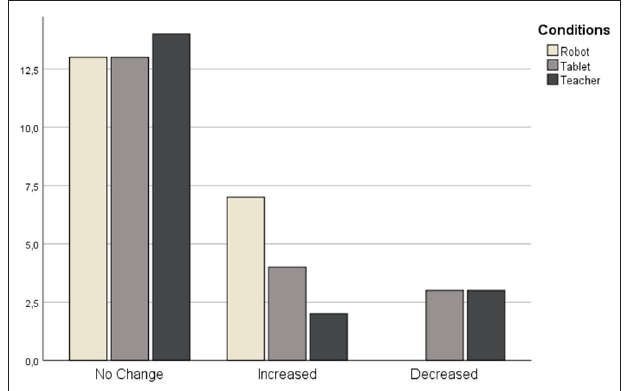
FIGURE 5 | Number of children from three conditions grouped by their mood